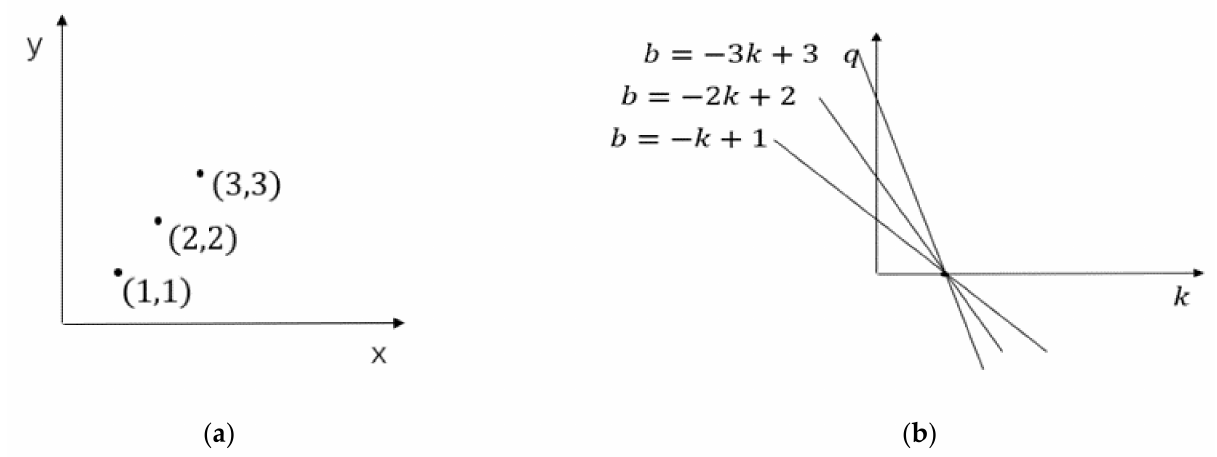
Figure 12. Schematic diagram of a Hough transformation in a cartesian coordinate system. ( a ) Cartesian coordinate system. ( b ) Hough Cartesian